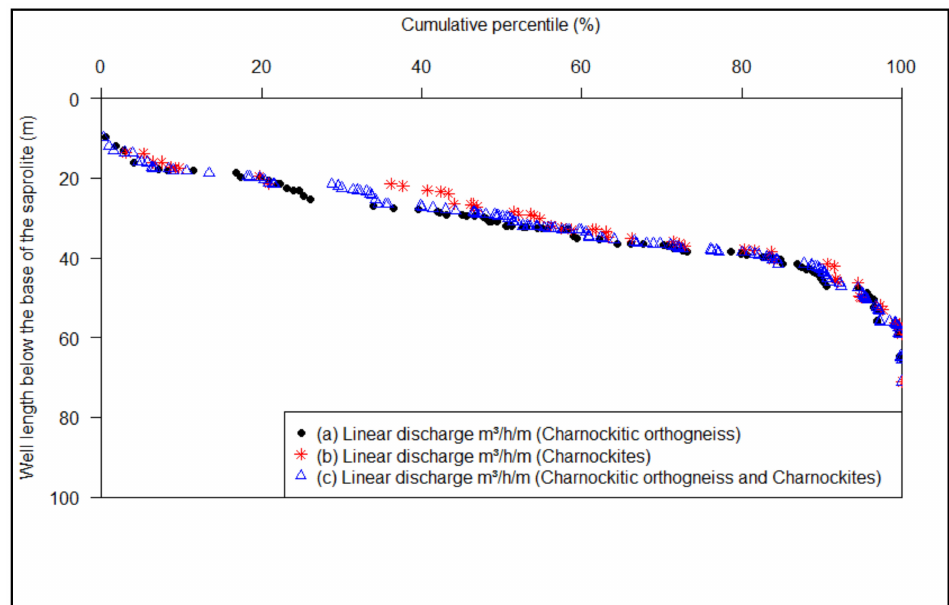
Figure 6. Cumulative percentage of linear discharge (X axis, %; see definition of the linear discharge in Section 2.2.4) as function of the length of the well below the base of saprolite (Y axis, m) for the lithologies: (a) Charnockitic orthogneiss (N = 93), (b) Charnockites (N = 52) and (c) Charnockitic Orthogneiss and Charnockites (N = 145).